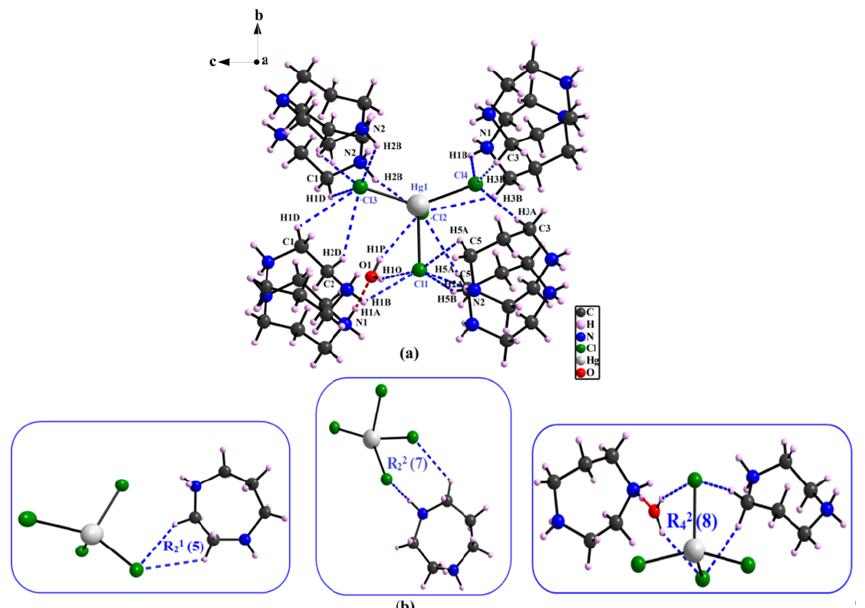
Figure 4. ( a )The intermolecular H-bonds between the organic cation (homopiperazinium) and chlorine anion (Cl − ), between the organic cation and H 2 O molecule, and between the water molecule and chlorine anion; ( b ) the different ring motifs in (C 5 H 14 N 2 )[HgCl 4 ]·H 2 O.